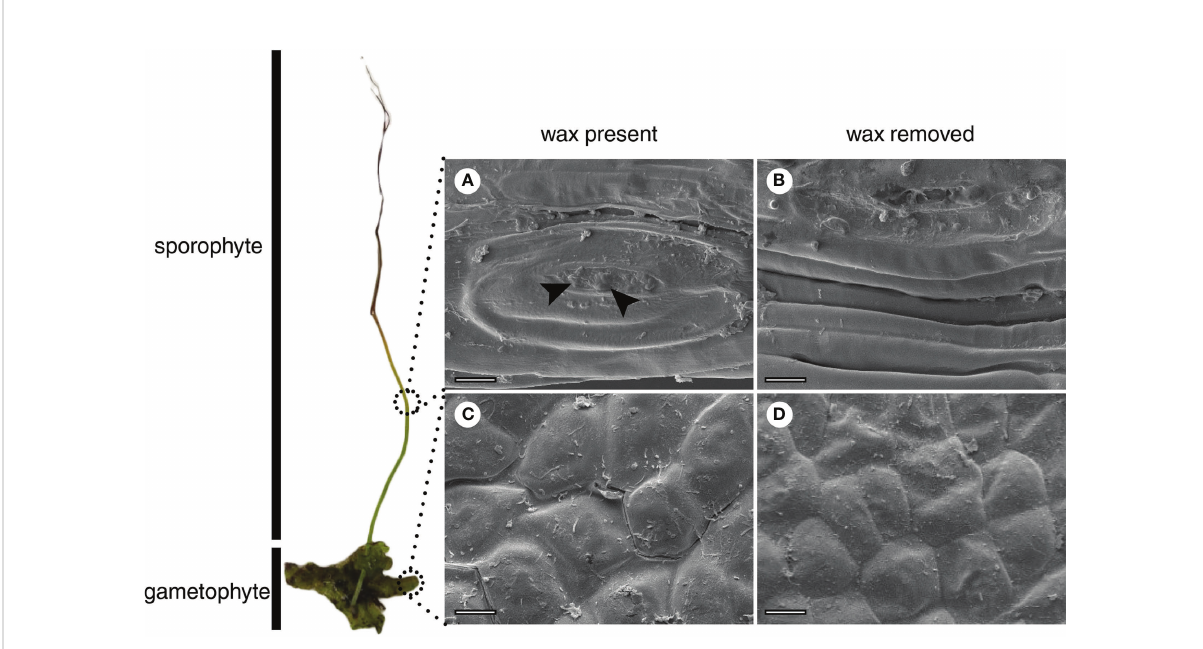
FIGURE 2 Scanning electron microscopy (SEM) of the surface of the sporophyte (A, B) and gametophyte (C, D) of Phaeoceros laevis . Images (A) and (C) correspond to samples with epicuticular wax, with fi lm-like morphology. Arrows indicate possible wax granules at the sporophyte opening (A) . Samples (B) and (D) were treated with chloroform. Bars: 20